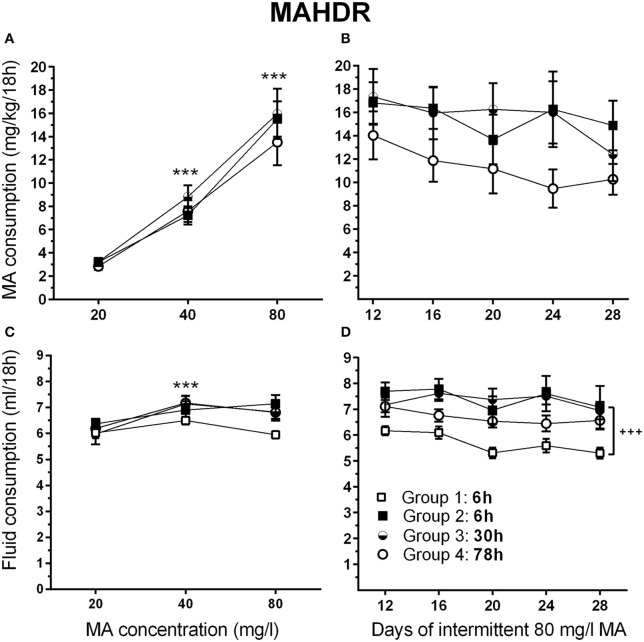
MA intake remains high in MAHDR mice under multiple intermittent MA withdrawal periods. (A) Mean (±SEM) mg/kg/18 h MA consumed for each MA concentration and group, during the MA drinking acquisition period; (B) Mean (±SEM) mg/kg/18 h MA consumed when access to 80 mg/l MA was separated by 6-, 30-, or 78-h withdrawal (abstinence) periods; (C, D) Corresponding mean (±SEM) total fluid consumed. Note: Group 1, 6 h (□) is water control group. The MA drinking group 2–4 designations are based on the variable withdrawal length after day 12. See Figure 1 for group information. ***p <0.001, compared to the next lower MA concentration; +++p <0.001, Group 2–4 compared to Group 1.